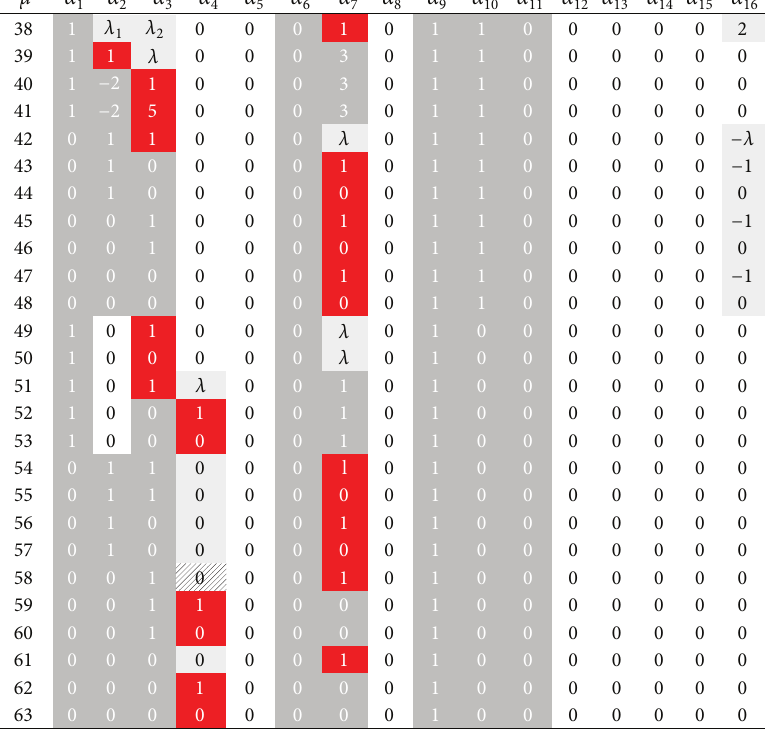
Figure 3: Case B.1.1: 𝛼 11 = 0 , 𝛼 9 ̸=0 , and 𝛼 6 ̸= 0 ; classification of the QFLA of dimension 9.